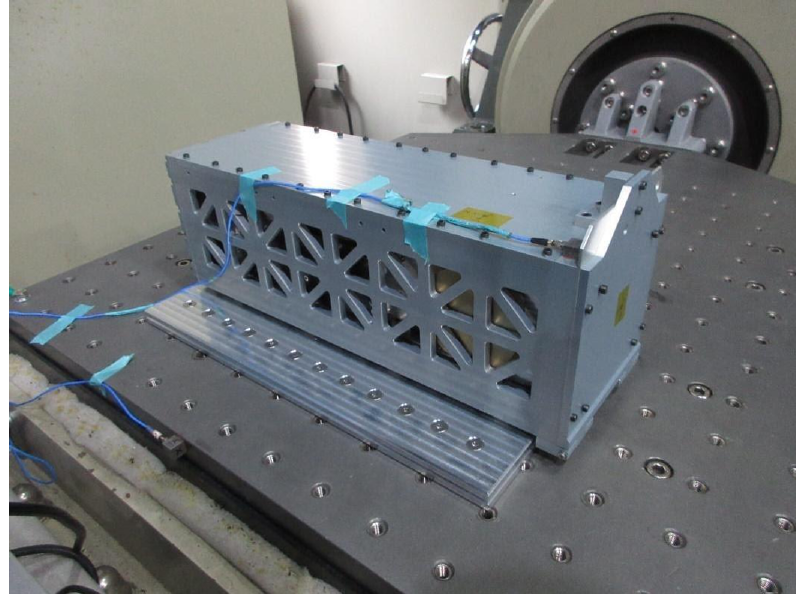
Figure 12. Vibration test setup for IDEASSat inside the TestPOD.